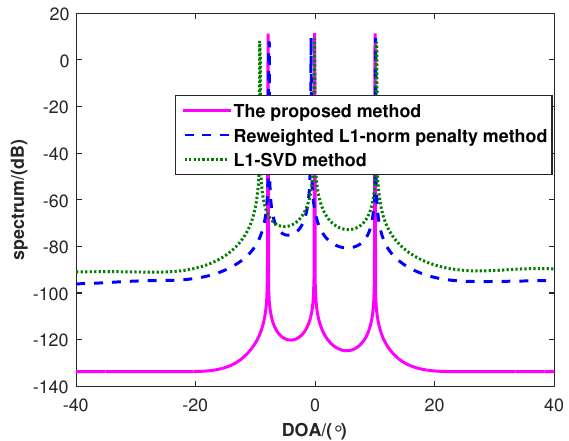
Figure 2. The spatial spectra of the l 1 -SVD method, the reweighted l 1 -norm penalty method and the proposed method.